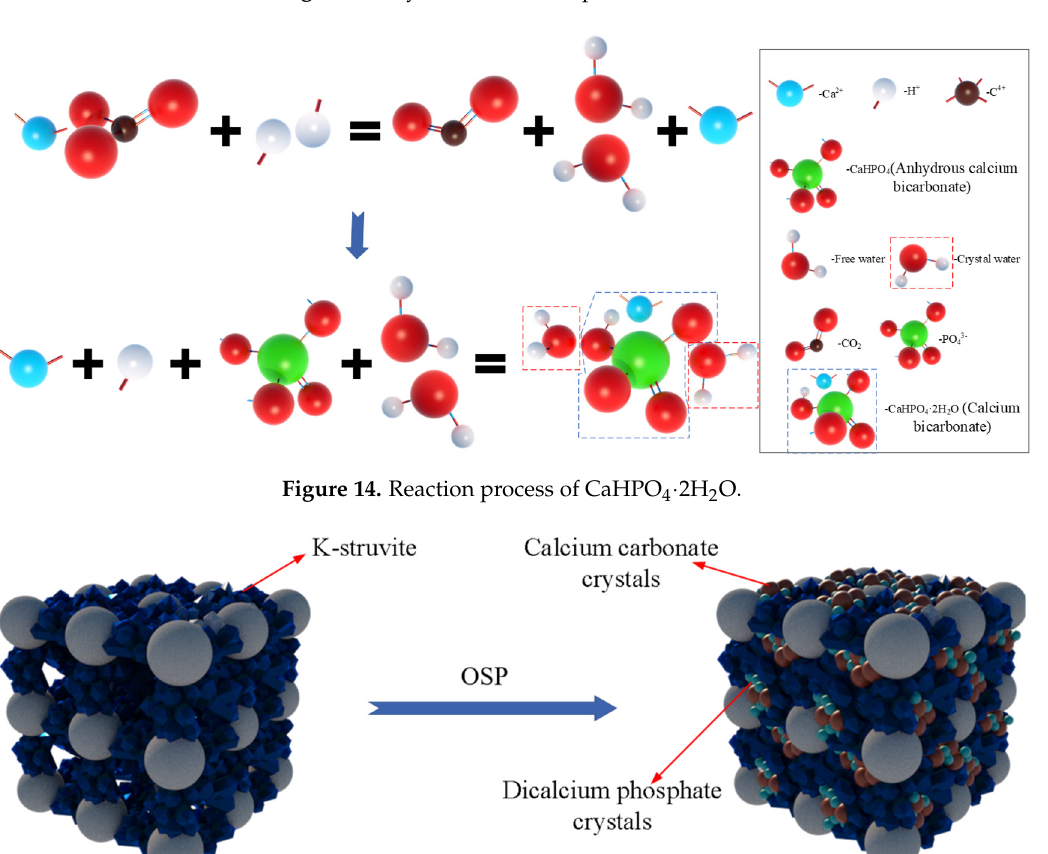
Figure 13. Hydration reaction process of MPC.